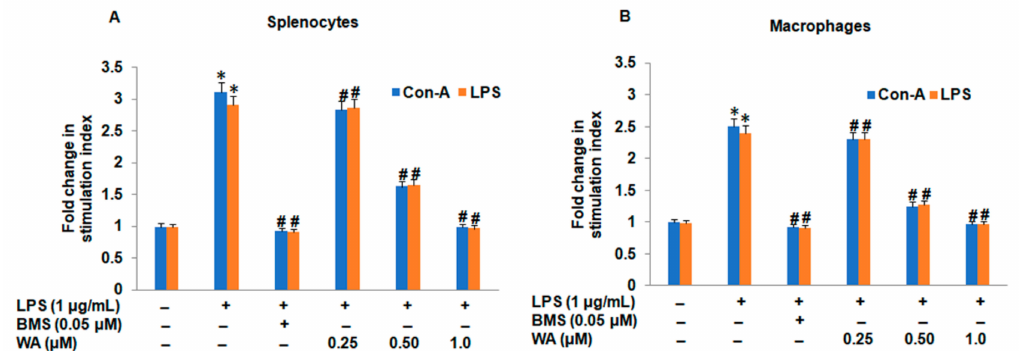
Figure 2. WA inhibits ConA/LPS-stimulated splenocytes and macrophage cell viability. ( A ) Isolated splenocytes were initially stimulated with mitogens LPS (1 µ g/mL) and Con5 (5 µ g/mL) to enhance the proliferation of spleen-derived lymphocytes (B and T cells) followed by treatment with varying doses of WA (0.25, 0.5, and 1.0 µ M) for 72 h along with positive control BMS (0.05 µ M) and LPS- stimulating splenocytes to evaluate cell viability. ( B ) Macrophages collected from the peritoneal cavity of mice were initially stimulated with LPS (1 µ g/mL) and Con5 (5 µ g/mL) mitogens to enhance their proliferation, followed by treatment with varying doses of WA (0.25, 0.5, and 1.0 µ M) for 72 h along with positive control BMS (0.05 µ M) and LPS-stimulating macrophages to evaluate cell viability. Experimental data are presented as the mean ± SEM of three independent experiments. * p ≤ 0.05 (comparison vs. LPS only) and # p ≤ 0.05 (comparison vs. +LPS) are statistically